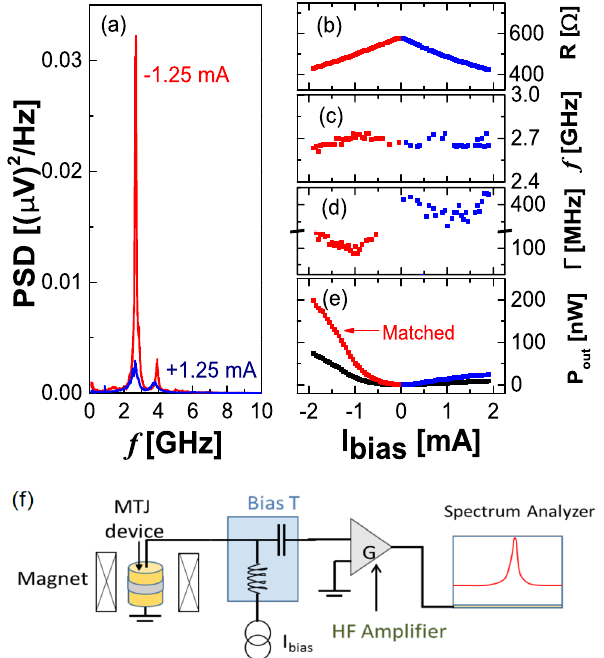
Figure 2. RF emission characterization. ( a ) Unmatched power spectral density measured at the amplifier input (PSD) with I bias = ± 1.25 mA. ( b ) Resistance, ( c ) frequency, ( d ) linewidth and ( e ) P out as a function of I bias . The red (blue) points represent the integrated P out matched to the load for negative (positive) I bias , while the black points represent the non-matched power. The magnetic field was kept constant (16 kA/m) in a direction close to the easy axis. ( f ) Schematic representation of the experimental setup used for the RF emission